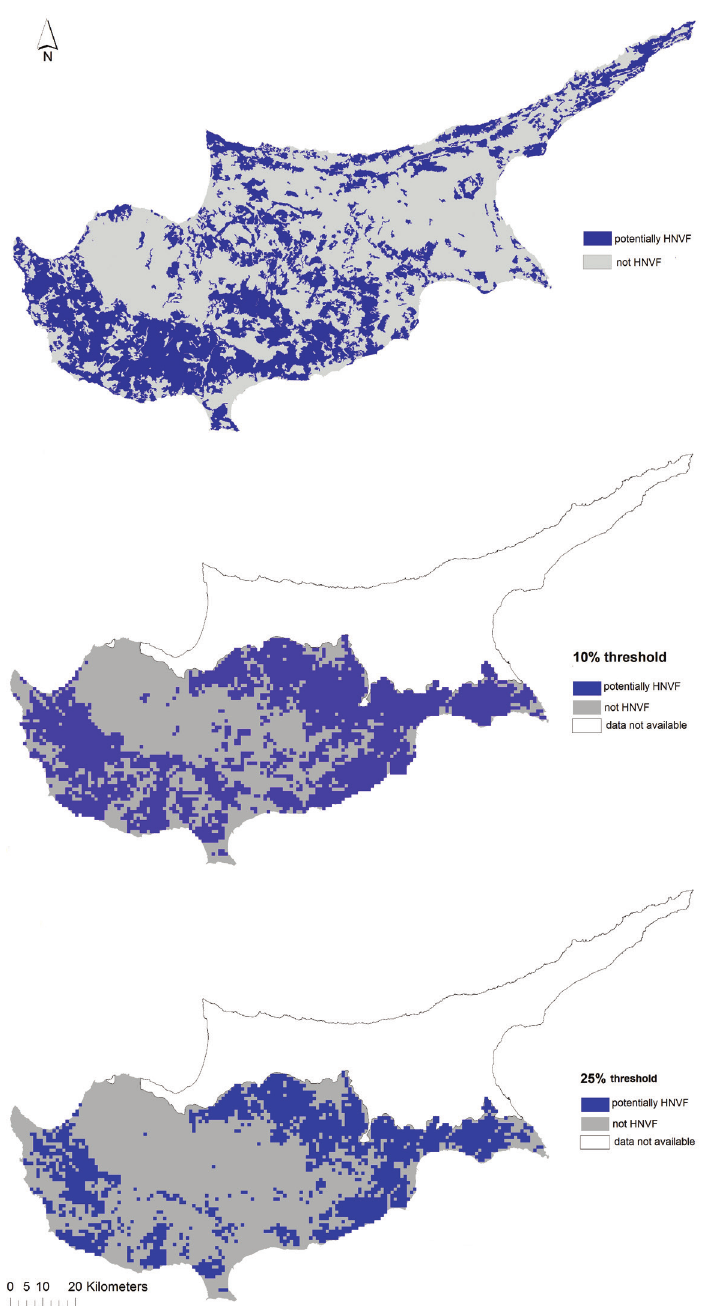
Figure 2. Extent of potentially HNVfs proposed by JRC (upper part) and potentially HNVfs according to the 10% threshold (middle part) and 25% thresholds in this study (lower